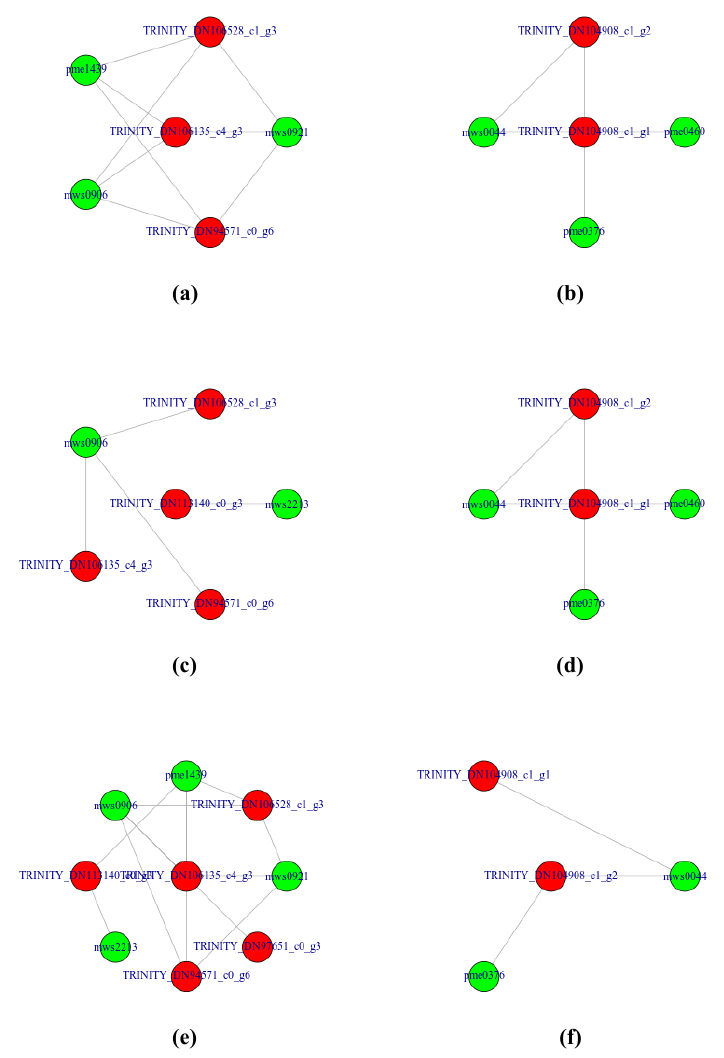
Figure 7. Transcript-metabolite correlation network representing DAMs and DEGs involved in WT and overexpression of LaMIR166a cell lines. ( a , b ) Pearson correlation network representing ko00940 and ko00941 in WT vs. a-3. ( c , d ) Pearson correlation network representing ko00940 and ko00941 in WT vs. a-4. ( e , f ) Pearson correlation network representing ko00940 and ko00941 in WT vs. a-5. The gene–metabolite pairs were connected within the network by edges. Red nodes represent genes, and green nodes represent metabolites. Full lines represent positive